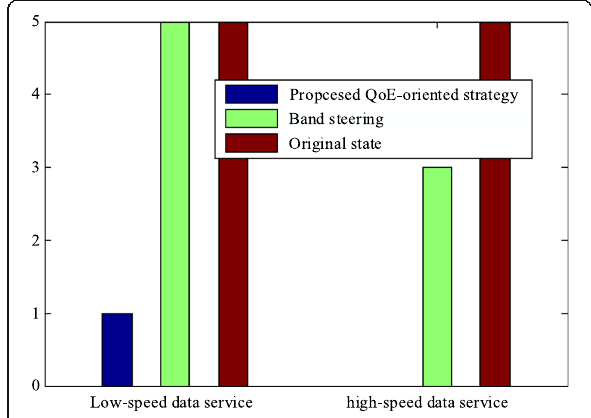
Fig. 9 QoE distribution of individual